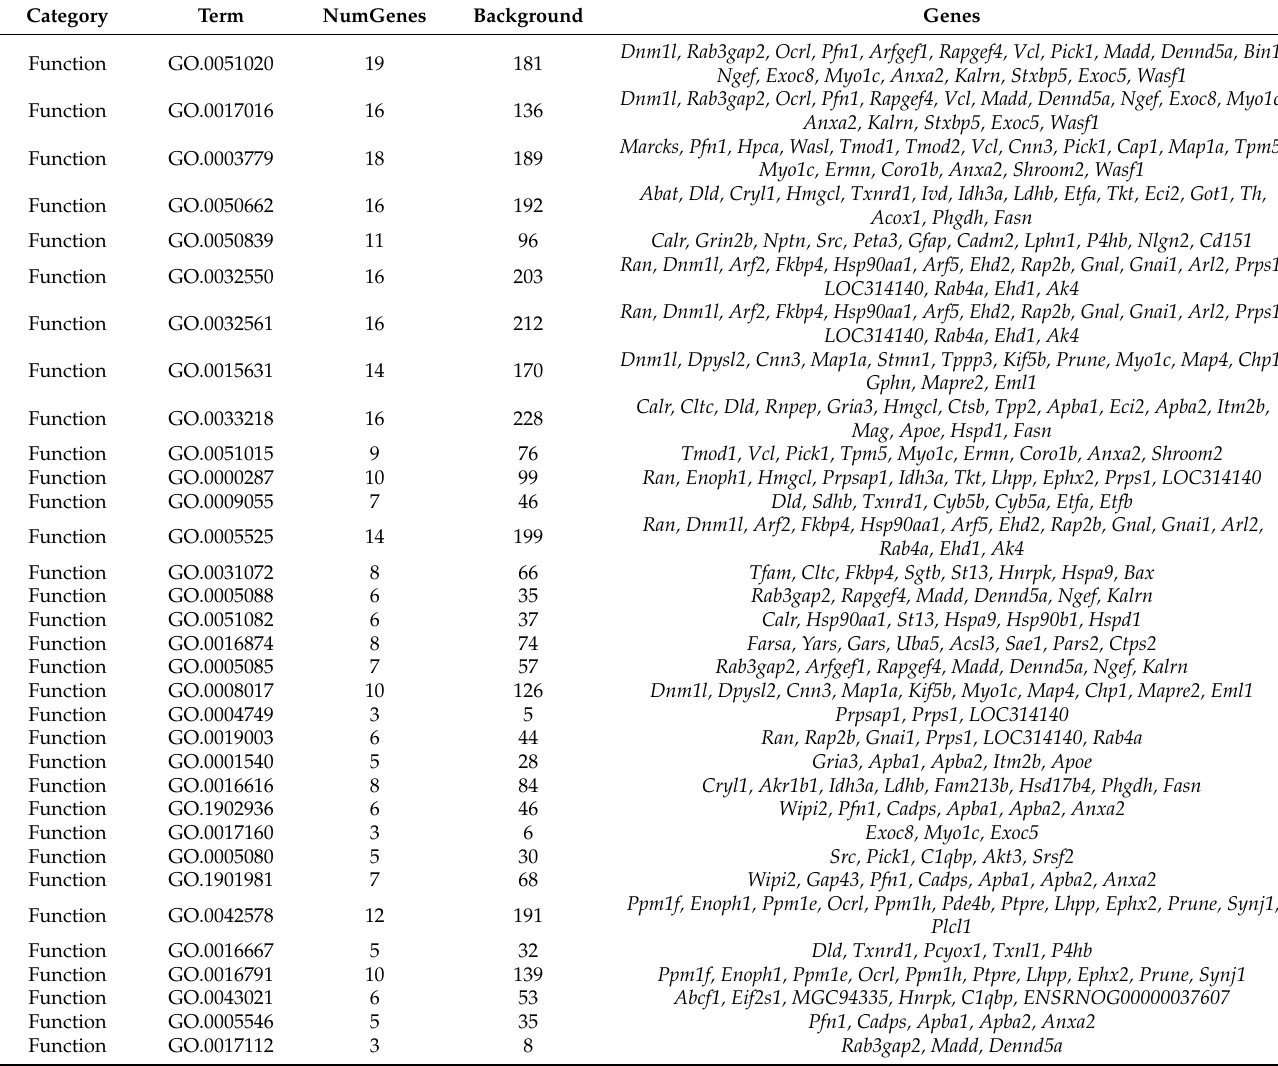
Table 2. Enrichment for all proteins which underwent significant changes ( p <